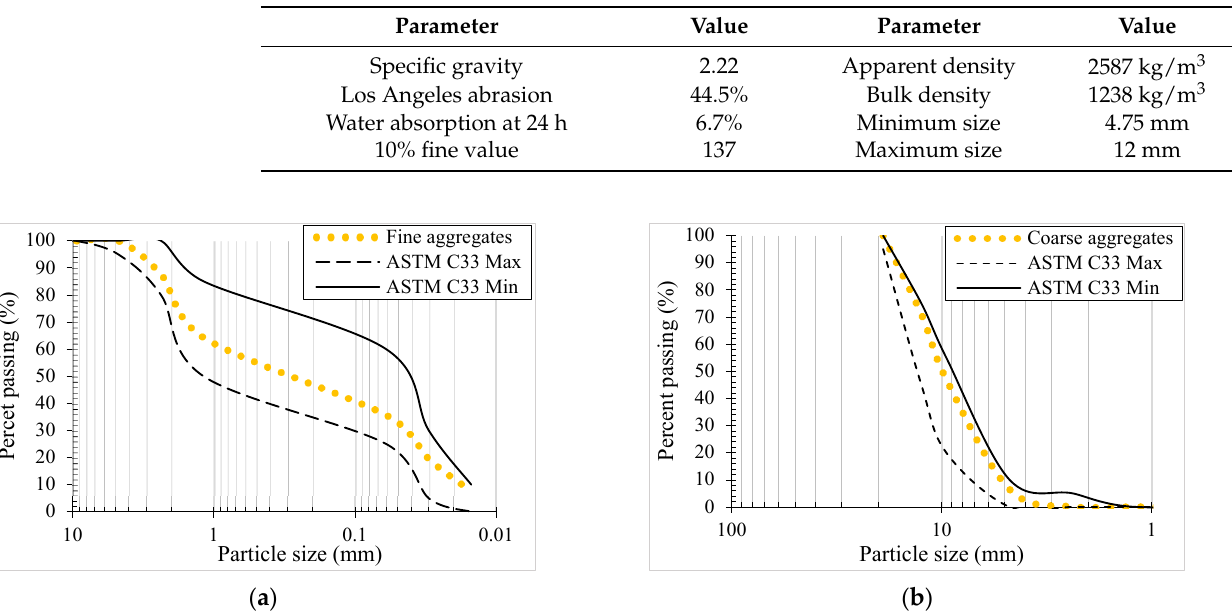
Figure 1. Granulometry ( a ) fine aggregates ( b ) RCA (C33 indicates the ASTM code, C33 Max and C33 Min indicate the maximum and minimum allowed passing percentages from the specific standard sieves). Table 1. Properties of RCA. Table 2. Mix proportions for RAGC (kg/m 3 ).